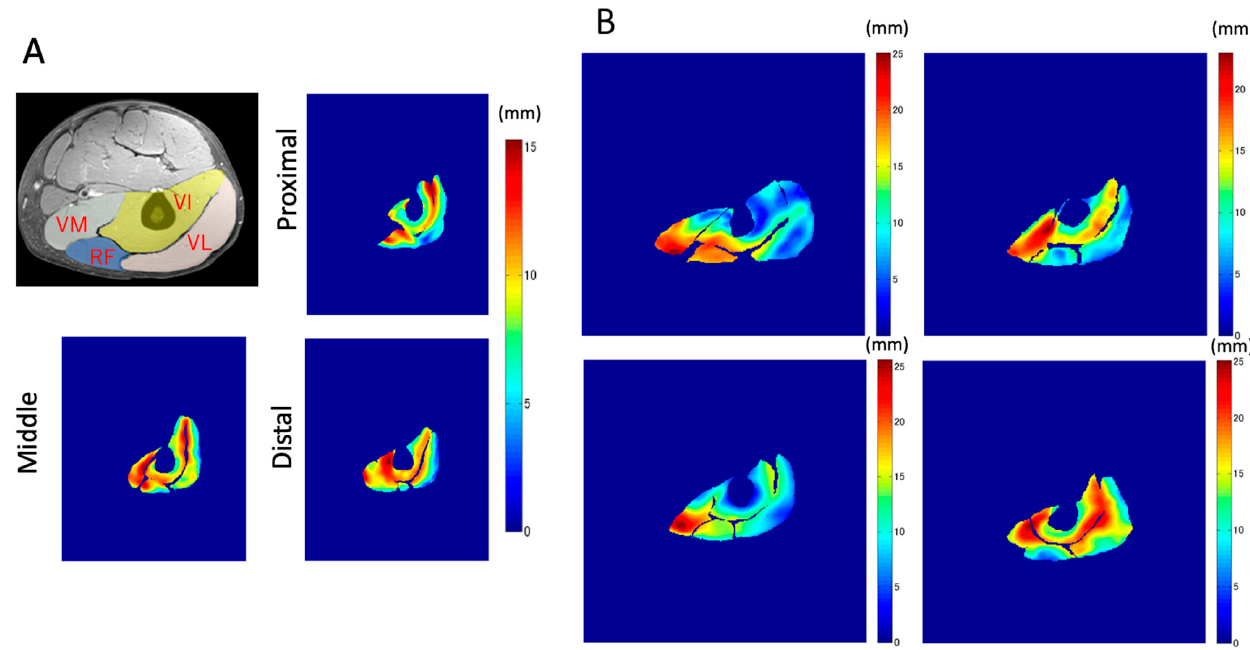
Figure 7. Examples of the maximal displacement at voxel level superimposed upon the static anatomical shape. ( A ) The distribution in the three different sections, proximal, middle, and distal in the same subject. ( B ) Examples of the middle section in four different subjects.